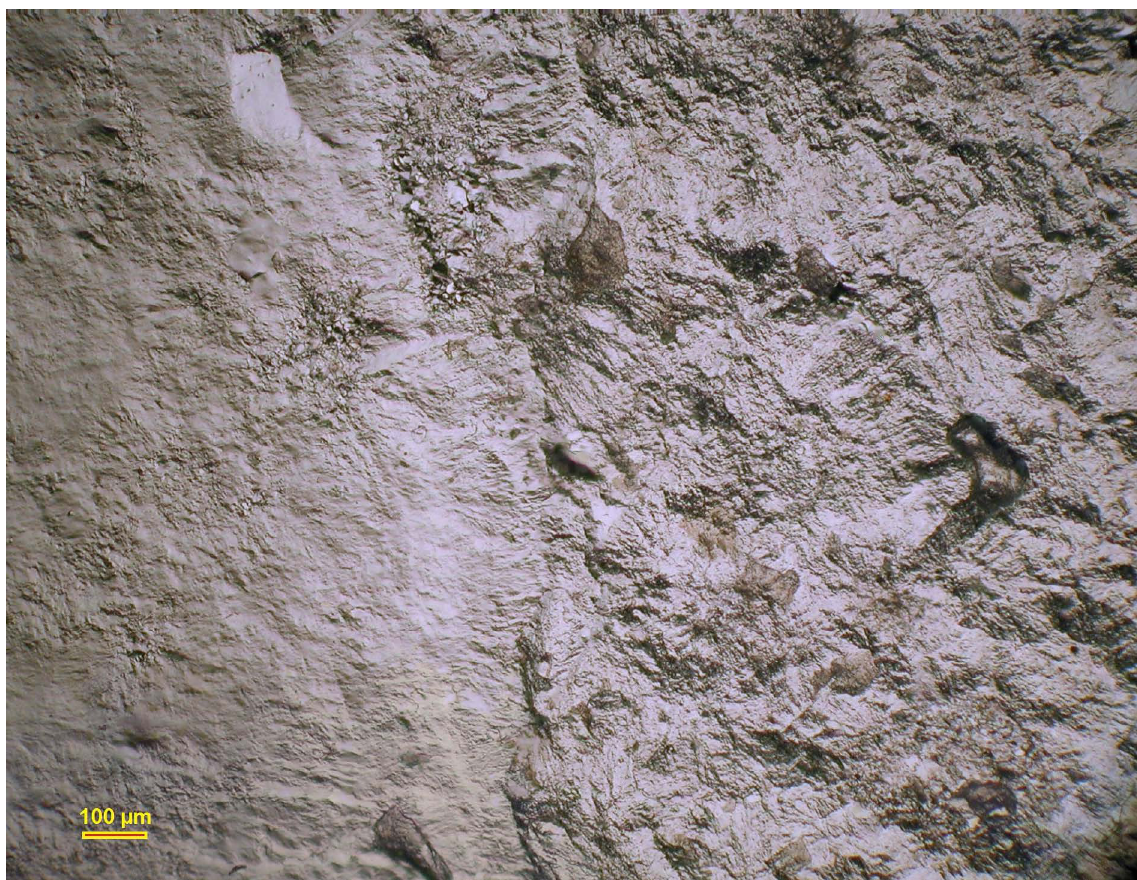
Figure 1. Surface structure of smooth (l) and dull surface (r) of experimental Grand-Pressigny point. The micrograph is prepared using a dark field mask with a slit in the middle to create both scattered and directly transmitted light (photo and acetate peel H. de Kruijk). Table 1. Surface roughness measurements of twelve heated points (settings: R a =3, R t =10, scale range 0.8-4.8